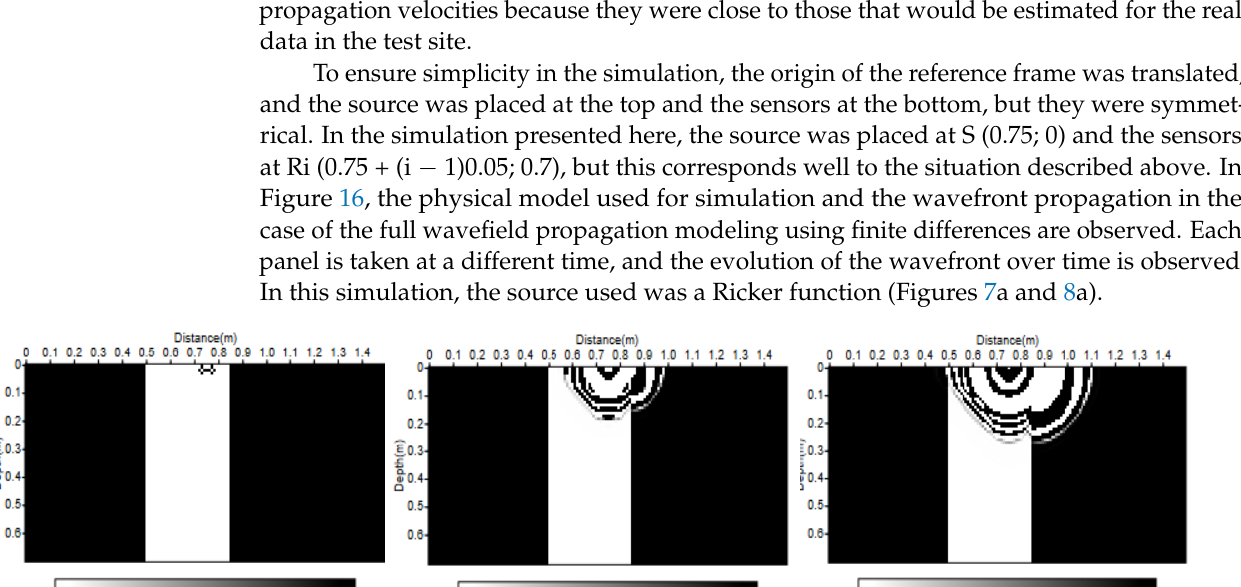
Figure 16. Physical velocity model and wavefront in the case of the full P-wavefield propagation modeling using the finite differences method.